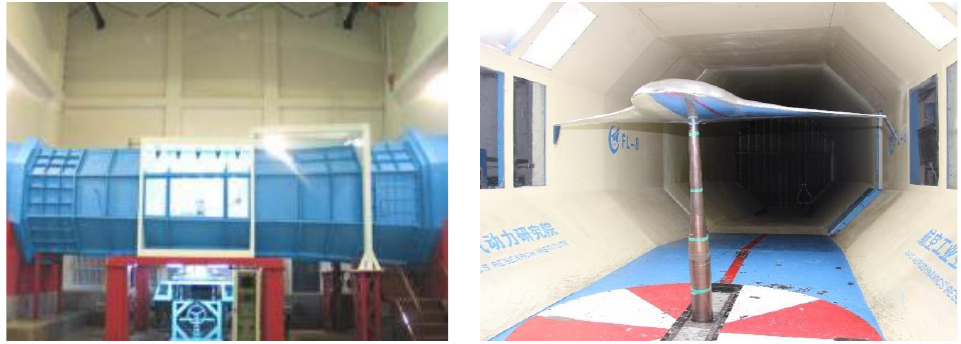
Figure 14 . Wind tunnel test in